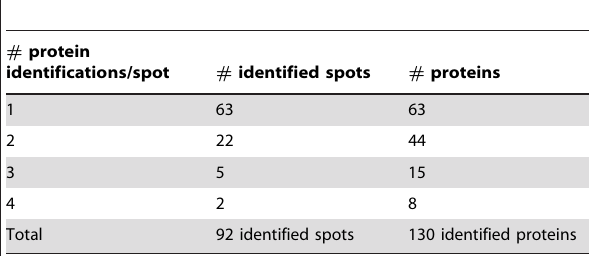
Table 1. Identification of differentially expressed protein spots (A #